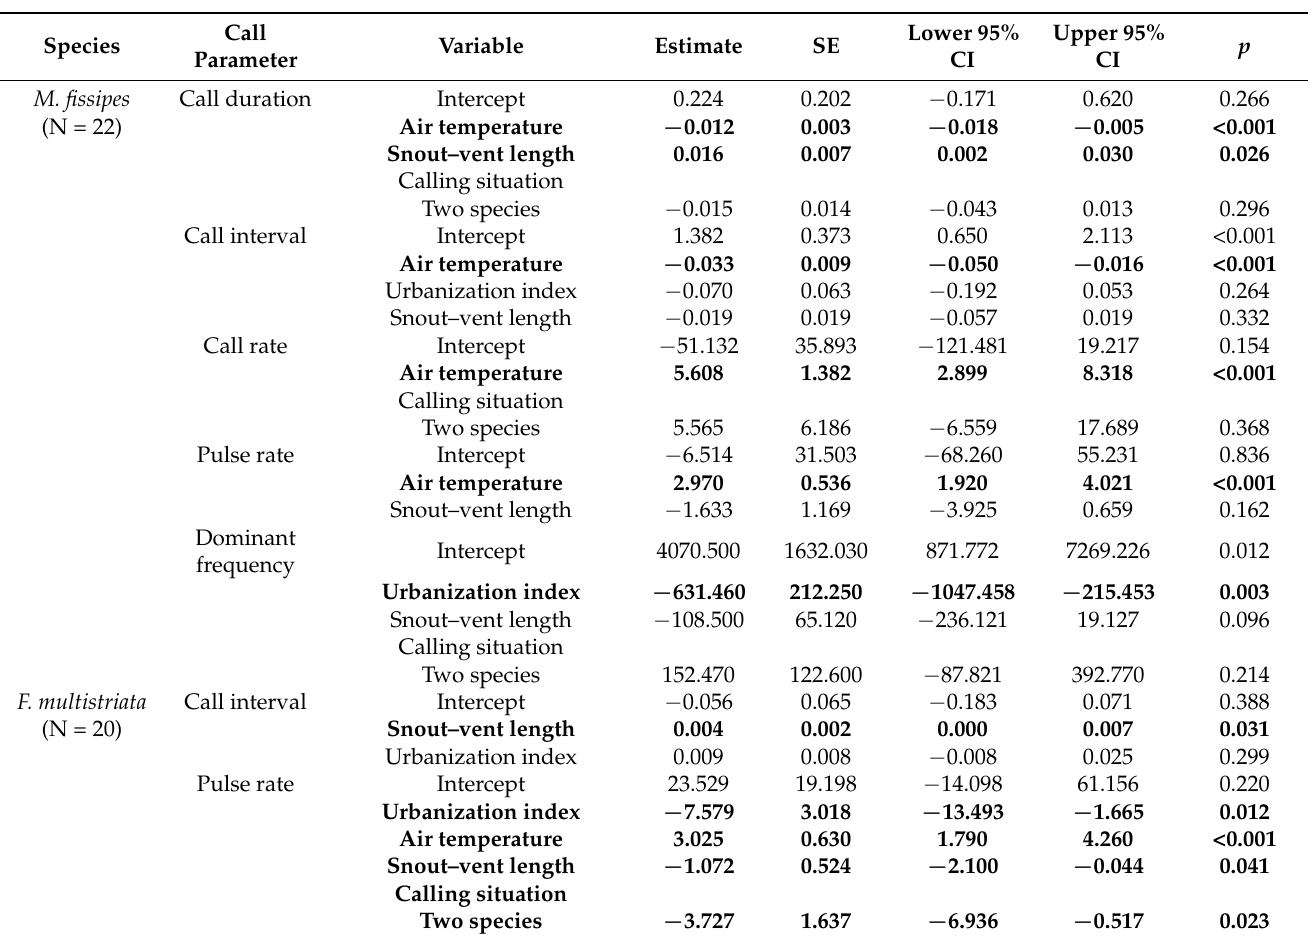
Table 3. Model-averaged estimates of the coefficient of predictors in the best models ( ∆ AICc < 2) between advertisement call parameters and variables (urbanization index, air temperature, snout– vent length, calling situation). Estimated coefficients, standard errors (SE), upper and lower 95% confidence intervals (CIs) and p value ( P ) in the most parsimonious models are shown for each species. Bold type indicates significant